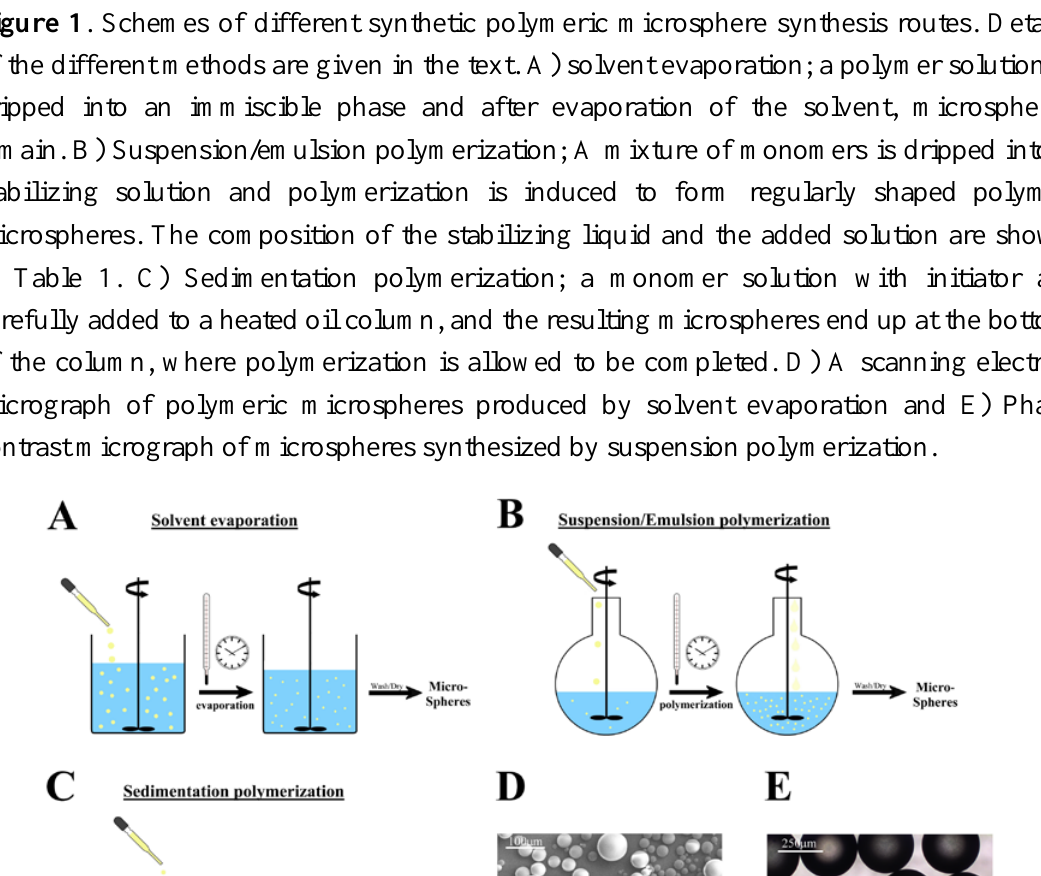
Figure 1 . Schemes of different synthetic polymeric microsphere synthesis routes.